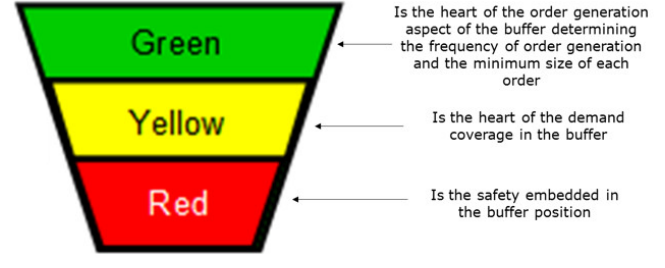
Figure 3. Zones of the buffer (Ptak & Smith,